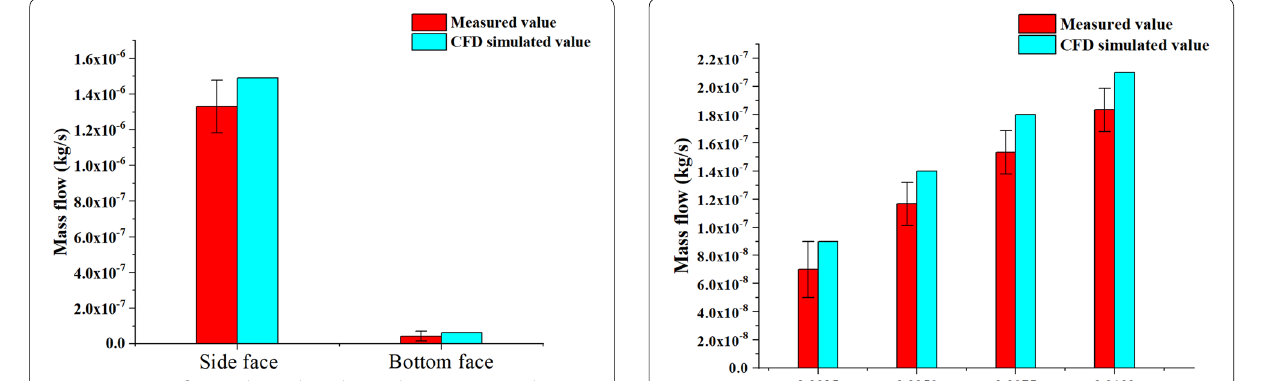
Figure 13 Mass flow in the outlets obtained using CFD simulation and actual measurement (the pore diameter is 434 μm)